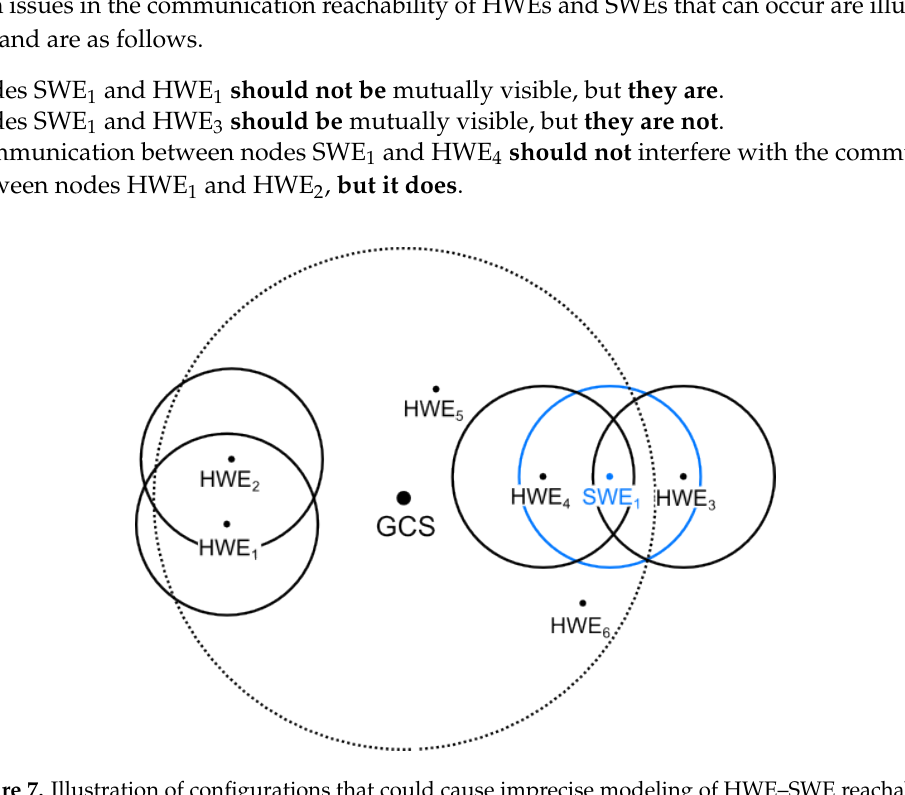
Figure 7. Illustration of configurations that could cause imprecise modeling of HWE–SWE reachability. Circles represent the communication ranges of individual entities and of the simulation platform (embodied by the